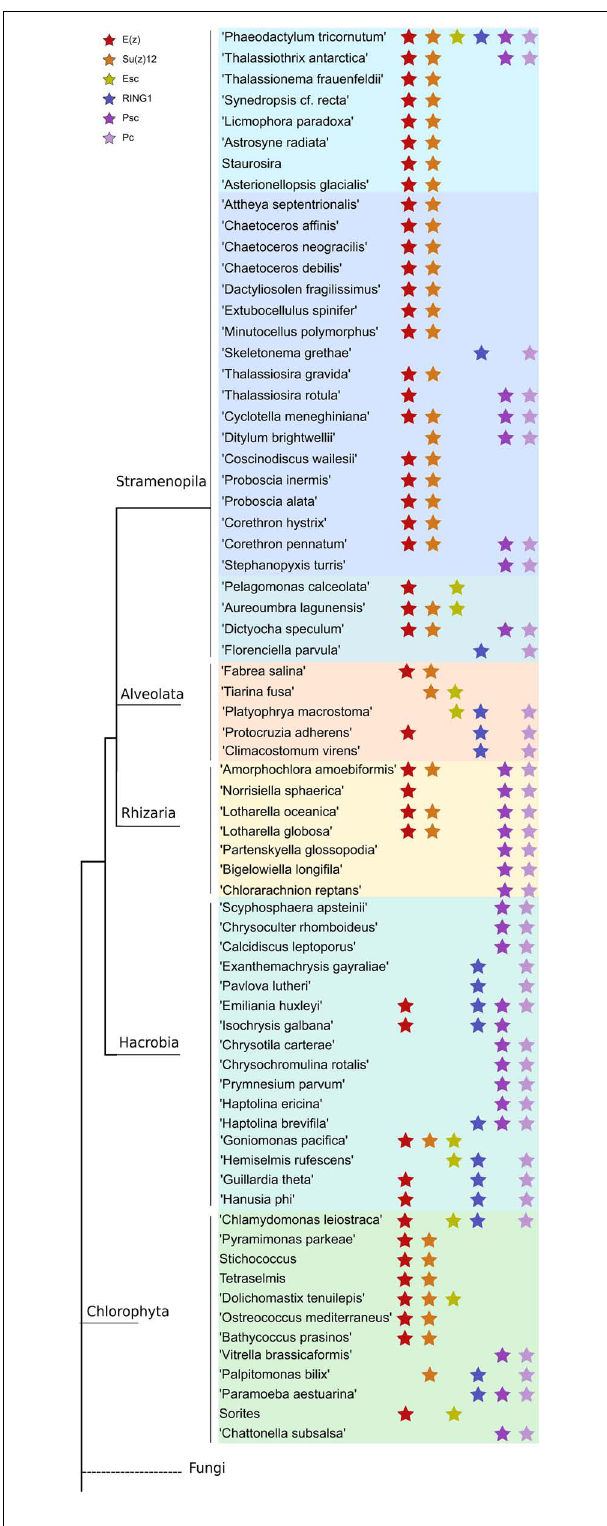
FIGURE 4 | Distribution of PRC1 and PRC2 components in a phylogenetic tree among microalgae species in MMETSP. Each star marks the presence of one component of either PRC1 or PRC2. Different color backgrounds represent species belongs to the same phylum or